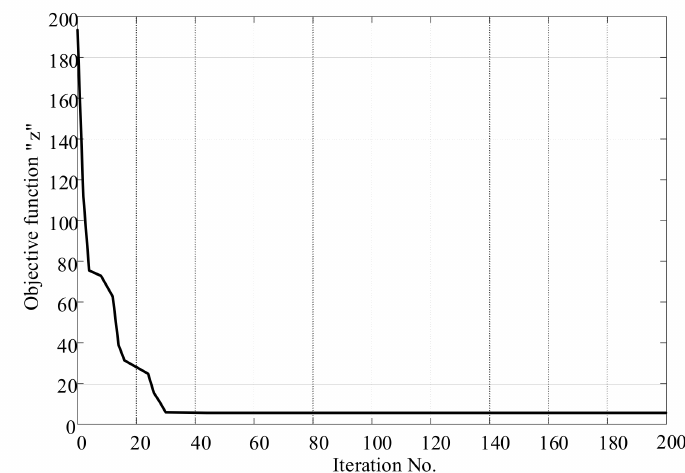
Figure 12. Convergence characteristic representation for Case 3.